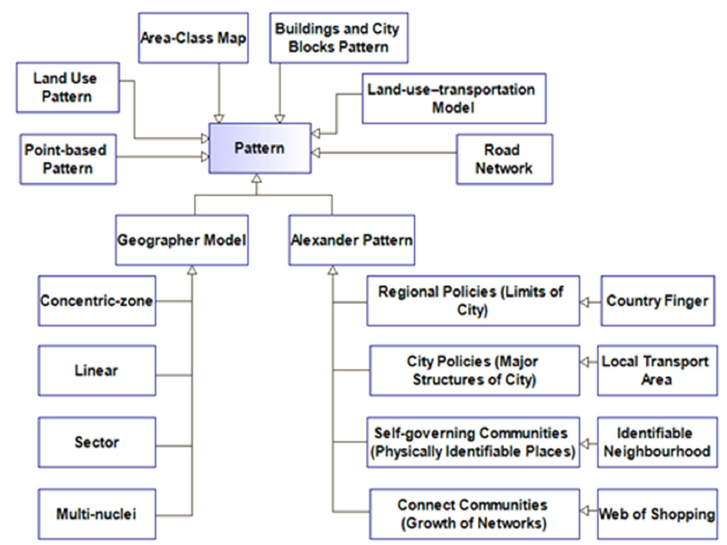
Figure 1. SP types and examples (UML class diagram).